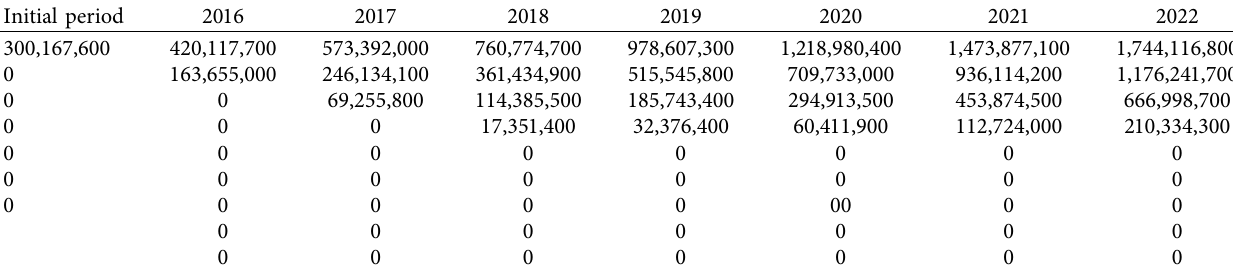
Table 4: Real option value of tourism real estate project in each period (unit: yuan). Initial